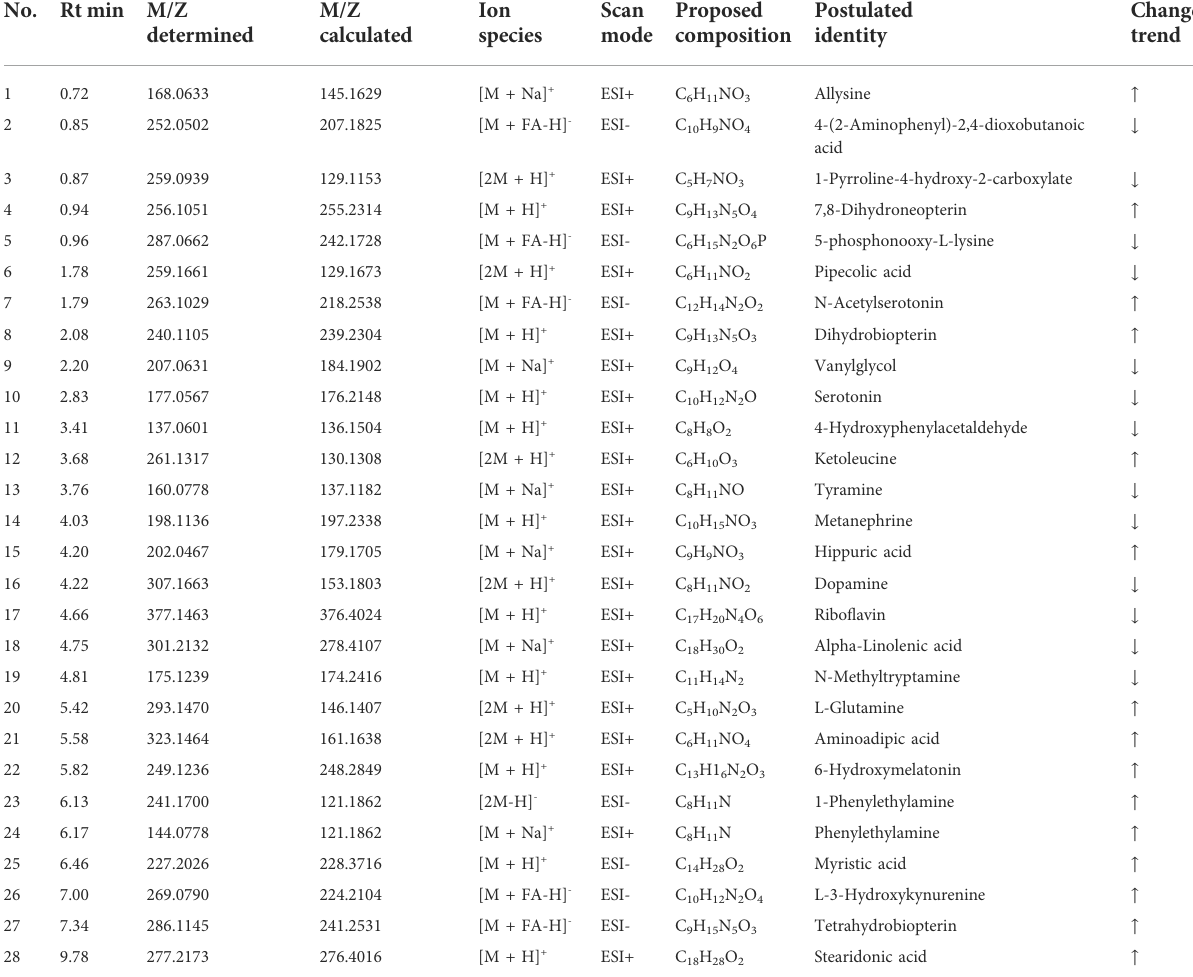
TABLE 1 Identi fi cation results and information of urine biomarkers in insomniac rats. No. Rt min M/Z